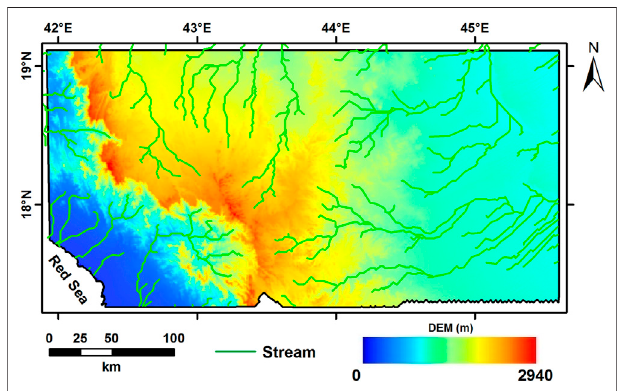
FIGURE 8 | Stream networks were extracted from SRTM 90 over the study